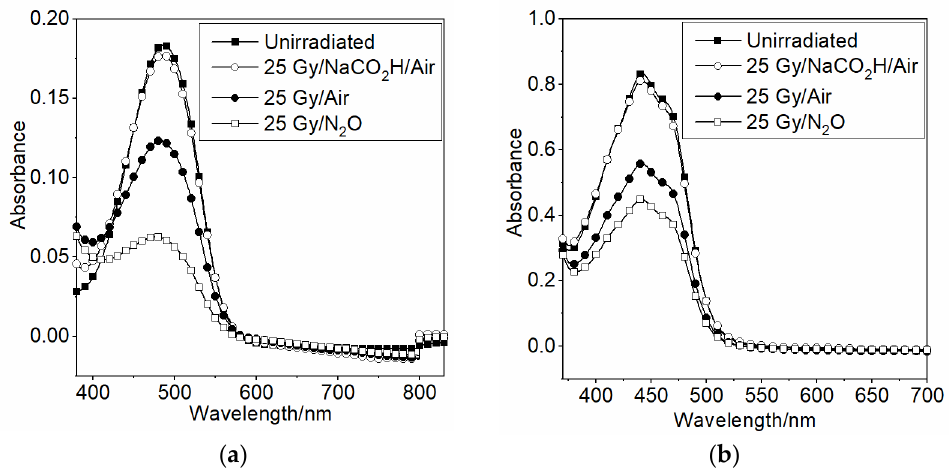
Figure 8. Absorbance of ( a ) astaxanthin in aqueous Triton-X 100 and ( b ) crocetin in water in the presence of sodium formate (generating O 2• − ) and absence of sodium formate (generating radicals presence of sodium formate (generating O 2 •− ) and absence of sodium formate (generating radicals including OH • ). including OH •